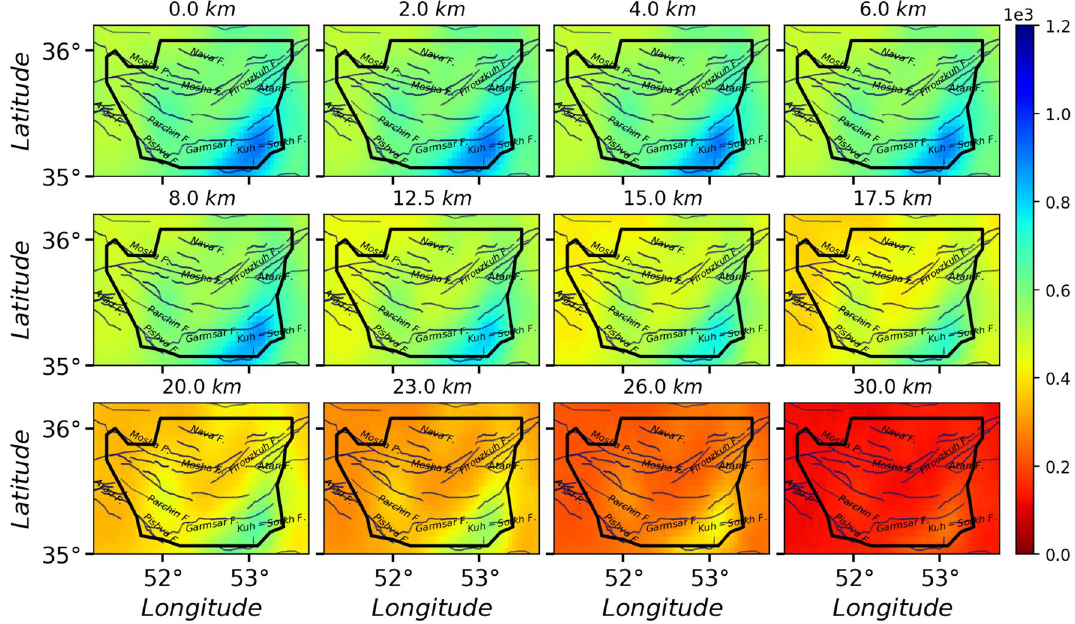
Figure 5. The activity Field for 1000000 avalanches in the whole space, wherein each avalanche starts from a random site. The solid lines and black border indicate the known faults and the region with good resolution, respectively.